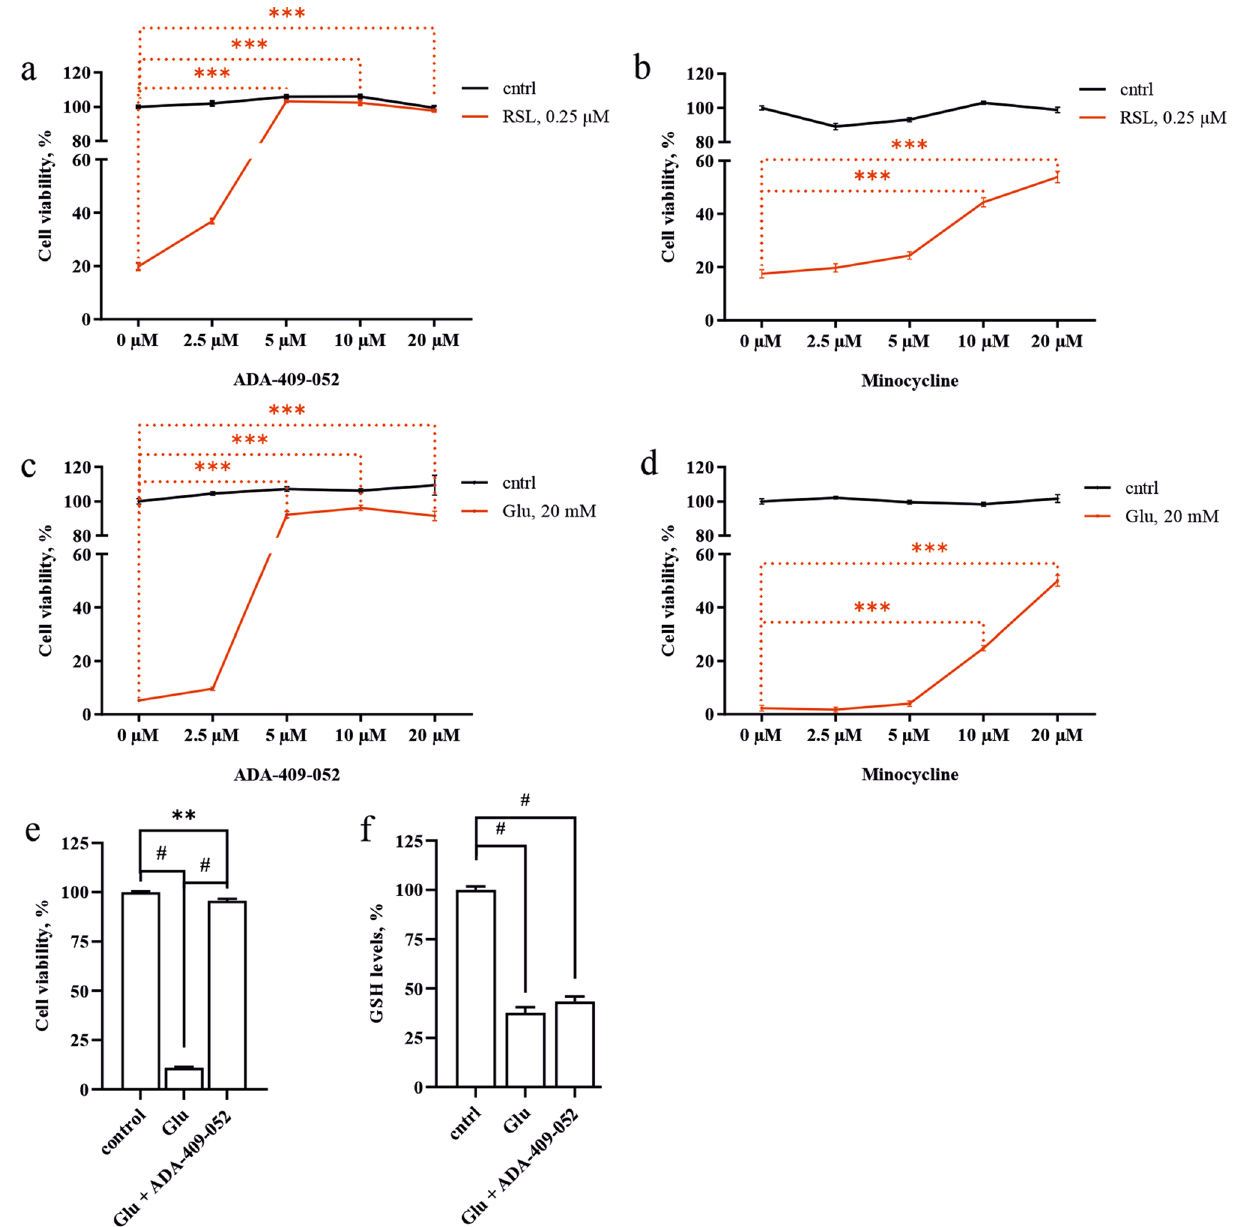
Figure 2. ADA-409-052 is protective against ferroptotic cell death in in vitro models of ferroptosis inducer class I and II. Increased cell viability, detected by the resazurin assay, illustrates the efficacy of ADA-409-052 on cultured PC-12 cells against either RSL3, a class II ferroptosis inducer inactivating GPx4, or glutamate, causing GSH depletion by inhibiting the system x c− . (a) ADA-409-052 protects PC-12 cells against RSL3-induced (0.25 µM) ferroptotic cell death significantly at all given concentrations (ADA-409-052: 2.5–20 µM). (b) Low concentrations of minocycline (2.5 or 5 µM) were inefficient against RSL3-mediated cell death. However, concentrations of 10 and 20 µM significantly improved cell survival. One-way ANOVA followed by Tukey’s multiple comparison test; data are presented as percentage ± s.e.m.; technical n = 6; ***p < 0.0001. (c) ADA-409- 052 (5–20 µM) prevented glutamate-induced (20 mM) ferroptotic cell death almost entirely. (d) Minocycline was only protective at concentrations of 10 and 20 µM. One-way ANOVA followed by Tukey’s multiple comparison test; data are presented as percentage ± s.e.m.; technical n = 6; ***p < 0.0001. (e,f) Glutamate- induced reduction of intracellular GSH-levels remains unchanged by ADA-409-052. Exposure of PC-12 cells to glutamate (20 mM) caused a major reduction of cell viability (f) and GSH levels (e) when compared with untreated control cells. While the cell viability was rescued almost entirely by the addition of ADA-409-052 (5 µM), the GSH levels remained comparable to glutamate-exposed cells. One-way ANOVA followed by Tukey’s multiple comparison test; data are presented as percentage ± s.e.m.; technical n = 6; **p = 0.0013; #p <